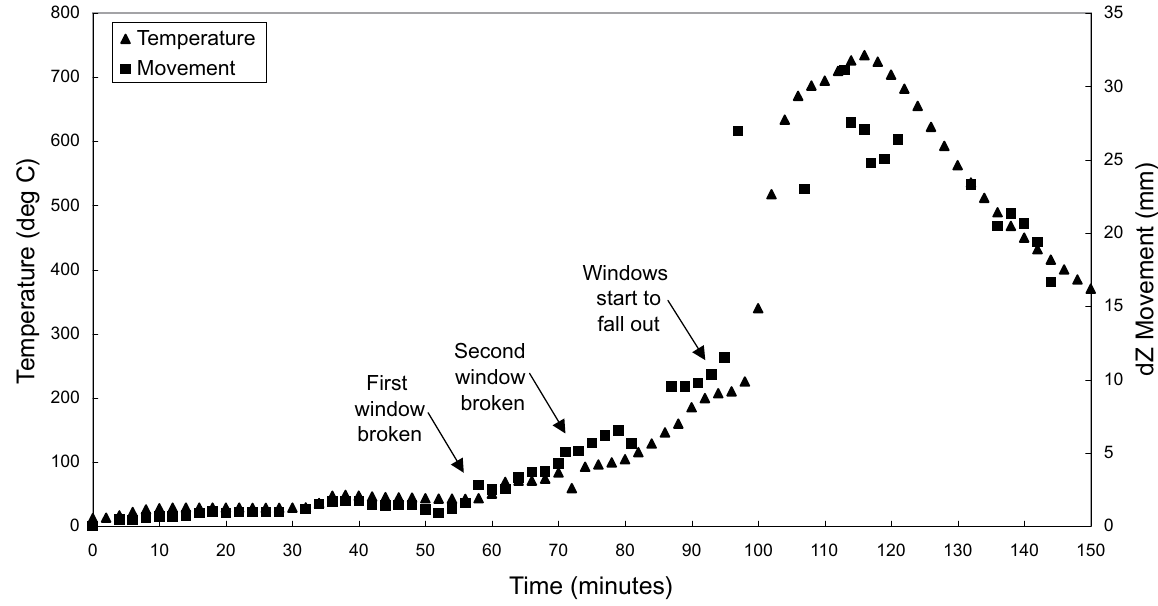
Fig. 8. Room temperature and wall displacement/ time plot for the Cardington corner room fire